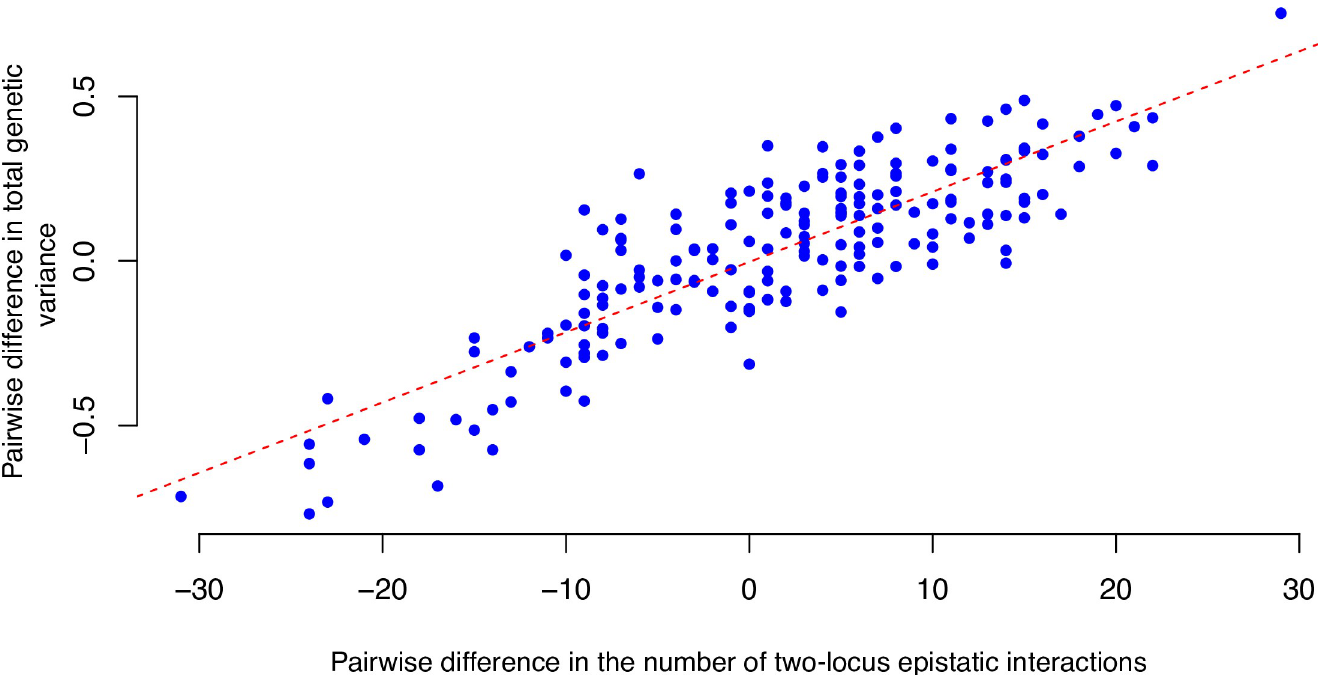
Fig 6. Illustration of the relationship between the activity of interactions in the epistatic network and amount of total genetic variance explained by the epistatic network across the growth environments. A significant correlation (P-value = 5.6 x 10 − 31 from regression) was detected between the pairwise differences in the number of active epistatic interactions (x-axis) and the total genetic variances (Vtotal1 –V total2 ; V total = H 2 ; y-axis) for the loci in the complete interaction network across the 20 environments.